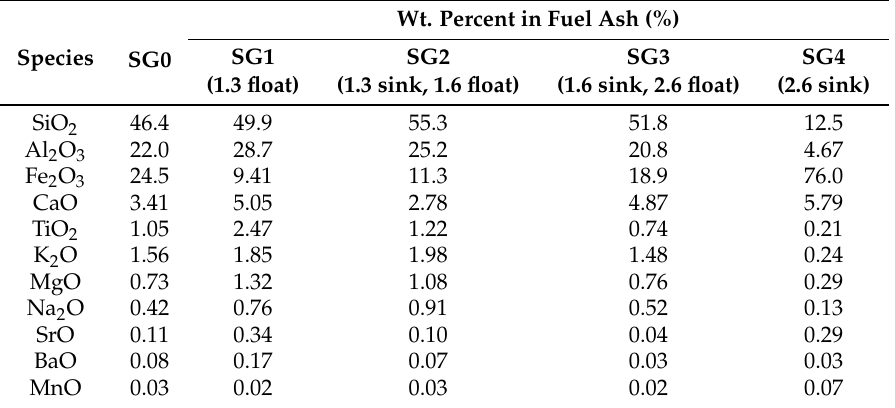
Table 1. Inductively coupled plasma atomic electron spectroscopy (ICP-AES) ash analyses of particle classes (75 to 106 µ m) of Pittsburgh seam coal